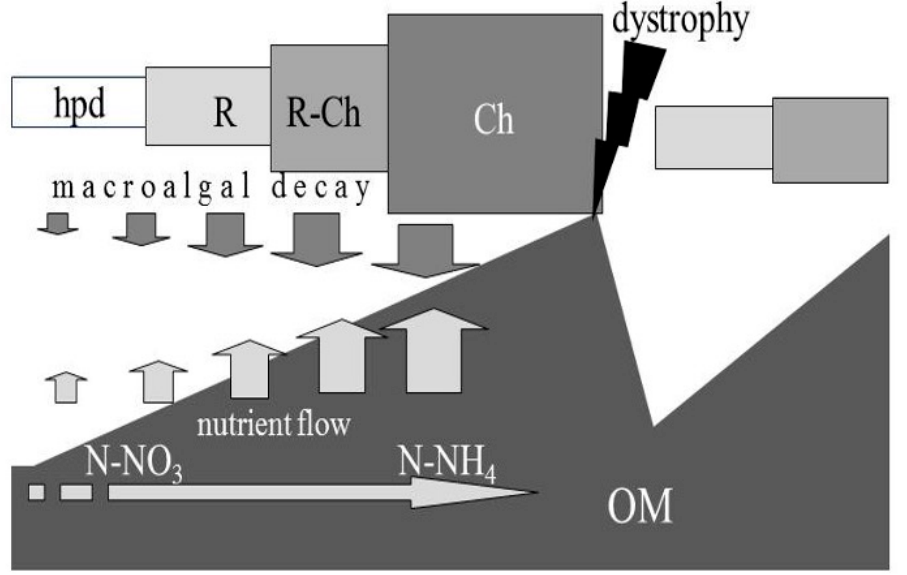
various chemical species of N and atomic ratio N:P values [9].